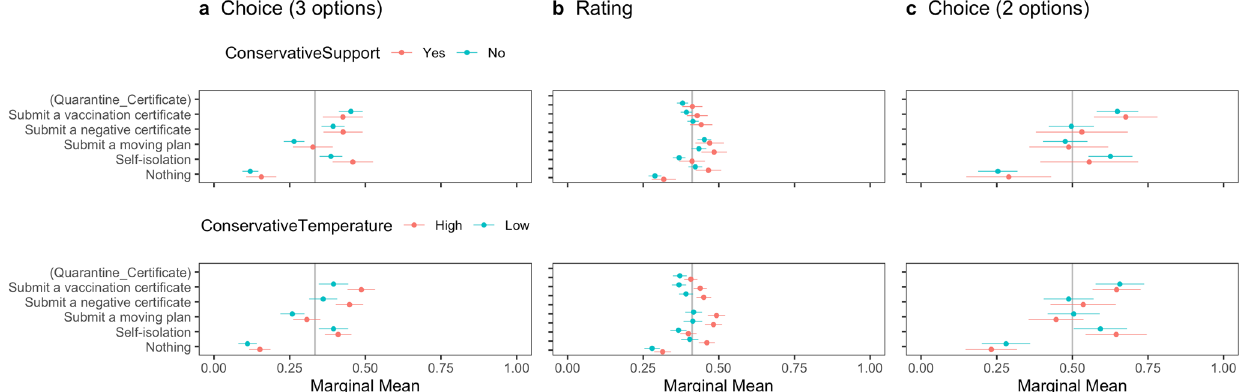
Fig. 6 Marginal means of the probability or rating for travelers ’ entry conditioned by conservative partisanship with error bars of 95% con fi dence intervals. The vertical line shows the random probability (0.33) for Panel a , the choice-based question (three options including “ Neither should be admitted ” ), the mean (0.41) for Panel b using the rating-based question, and the random probability (0.5) for Panel c , the choice-based question (two